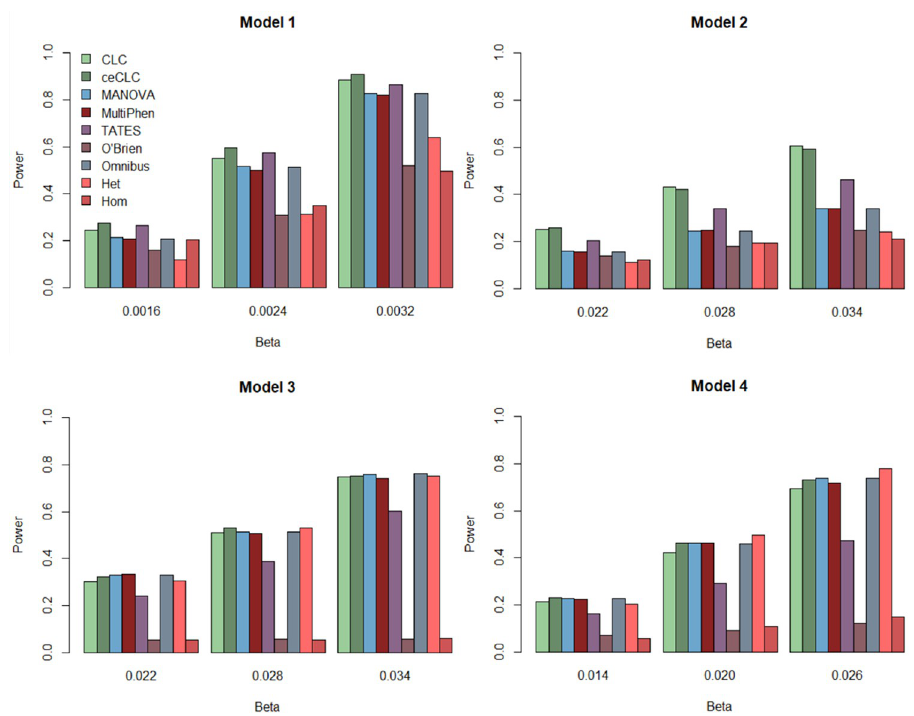
Fig 2. Power comparisons of the nine tests, CLC, ceCLC, MANOVA, MultiPhen, TATES, O’Brien, Omnibus, Het, and Hom with 10 quantitative and 10 qualitative phenotypes for the sample size of 5000.